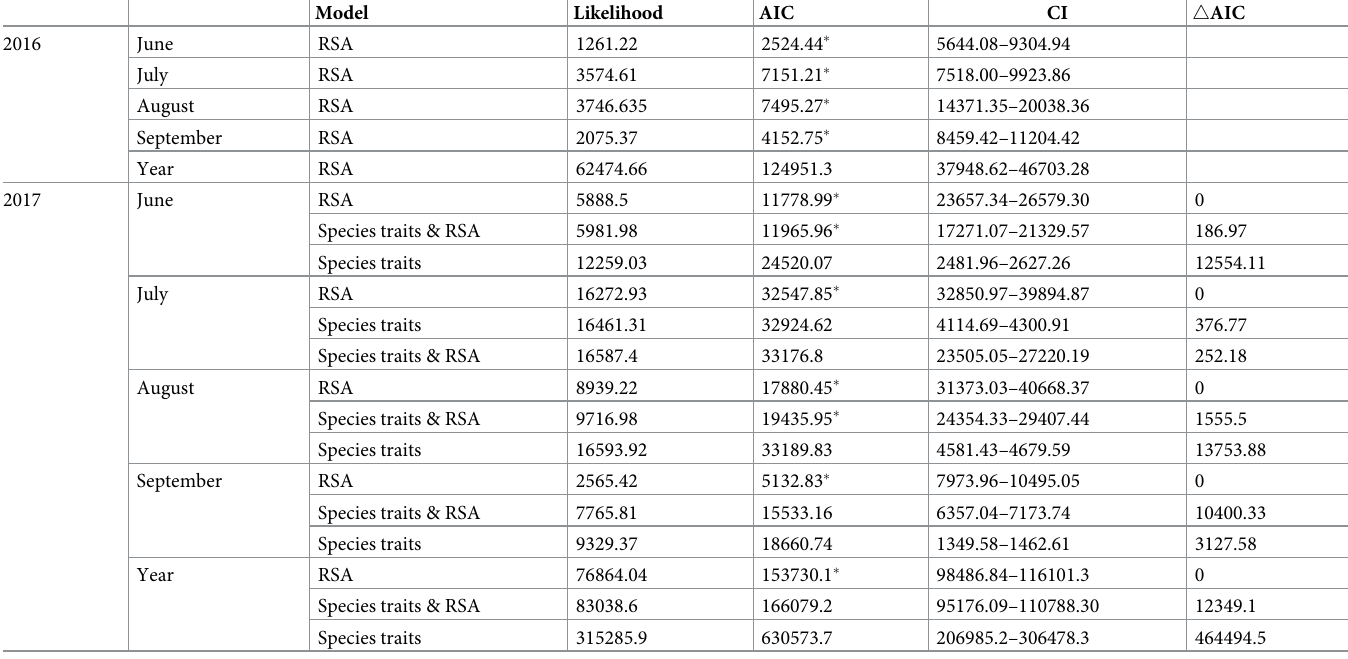
Table 2. Results of likelihood analyses showing whether relative species abundance (RSA), species traits, or their combination (Species traits & RSA), is a good indi- cator for pairwise